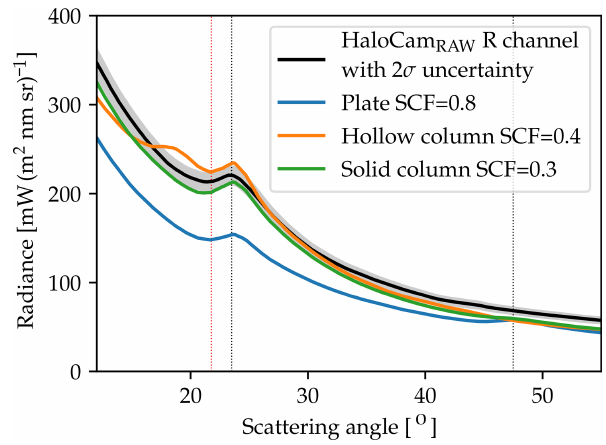
Figure 13. The black solid line displays the HaloCam RAW radi- ance in the principal plane above the sun from the scene shown in Fig. 11. The 2 σ uncertainty of the HaloCam RAW radiance is rep- resented by the gray shading around the black line. The scattering angles of the 22 and 46 ◦ halo peaks are indicated by the vertical black dashed lines. The red dashed line indicates the minimum of the 22 ◦ halo. The 22 ◦ halo ratio is computed by the ratio between the radiance values of the maximum and the minimum. The colored lines represent the radiance in the principal plane from the libRad- tran simulations shown in Fig. 12 (central column) for ice crystal plates (blue), hollow columns (orange), and solid columns